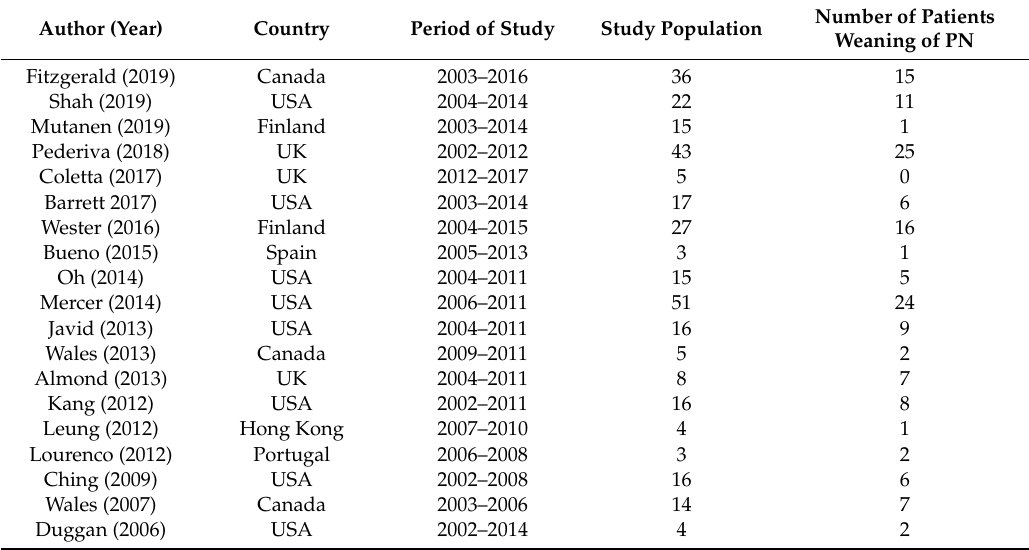
Table 2. Overview of the studies including patients treated with PN + AGIR.